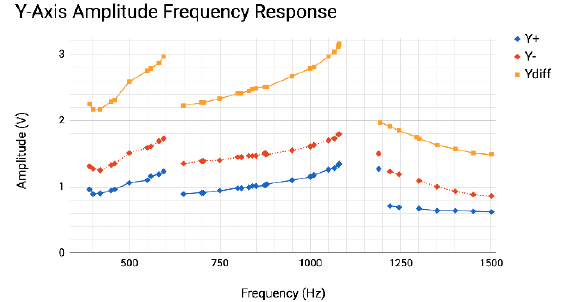
Figure 6. Increasing frequency amplitude response of each rotor–stator comb pair (diamonds) of the y -axis and the simultaneously recorded y -axis differential signal Y diff (squares), as measured by the 4MAPM, to demonstrate that the Y − (red) rotor–stator comb pair measured a larger minimum, maximum, and overall average capacitance change versus the Y+ (blue) comb pair.